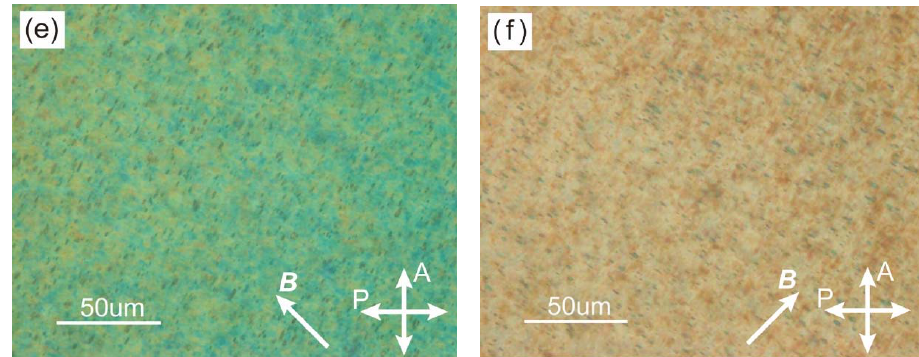
Figure 5. Polarized optical micrographs of ( a , b ) poly( L -lactic acid) under the 8-T static magnetic field (PLLA-8TS); ( c , d ) PPAZn/PLLA under no magnetic field (PPAZn/PLLA-0T); and ( e , f ) PPAZn/PLLA under the 8-T static magnetic field (PPAZn/PLLA-8TS). The micrographs of each sample were taken under the two optical settings indicated in each figure.